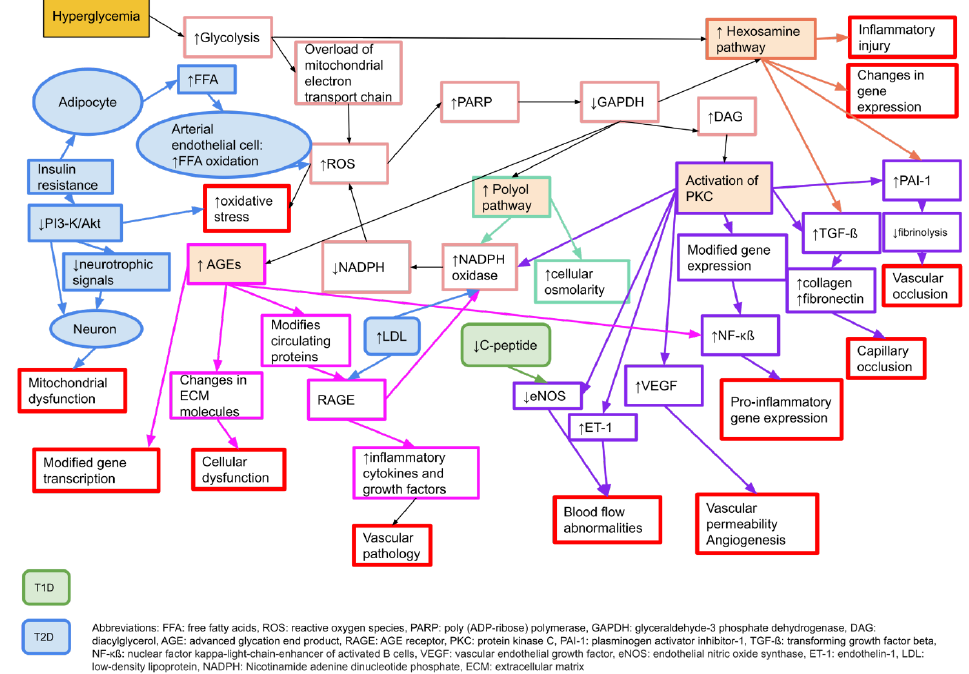
Figure 1. Molecular mechanisms behind microvascular complications in diabetes that may affect neurons, Schwann cells, and vascular endothelial cells, causing neuropathy or nerve dysfunction. Adapted from Zimmerman 2018 [26] with permission. T1D: type 1 diabetes, T2D: type 2 diabetes.